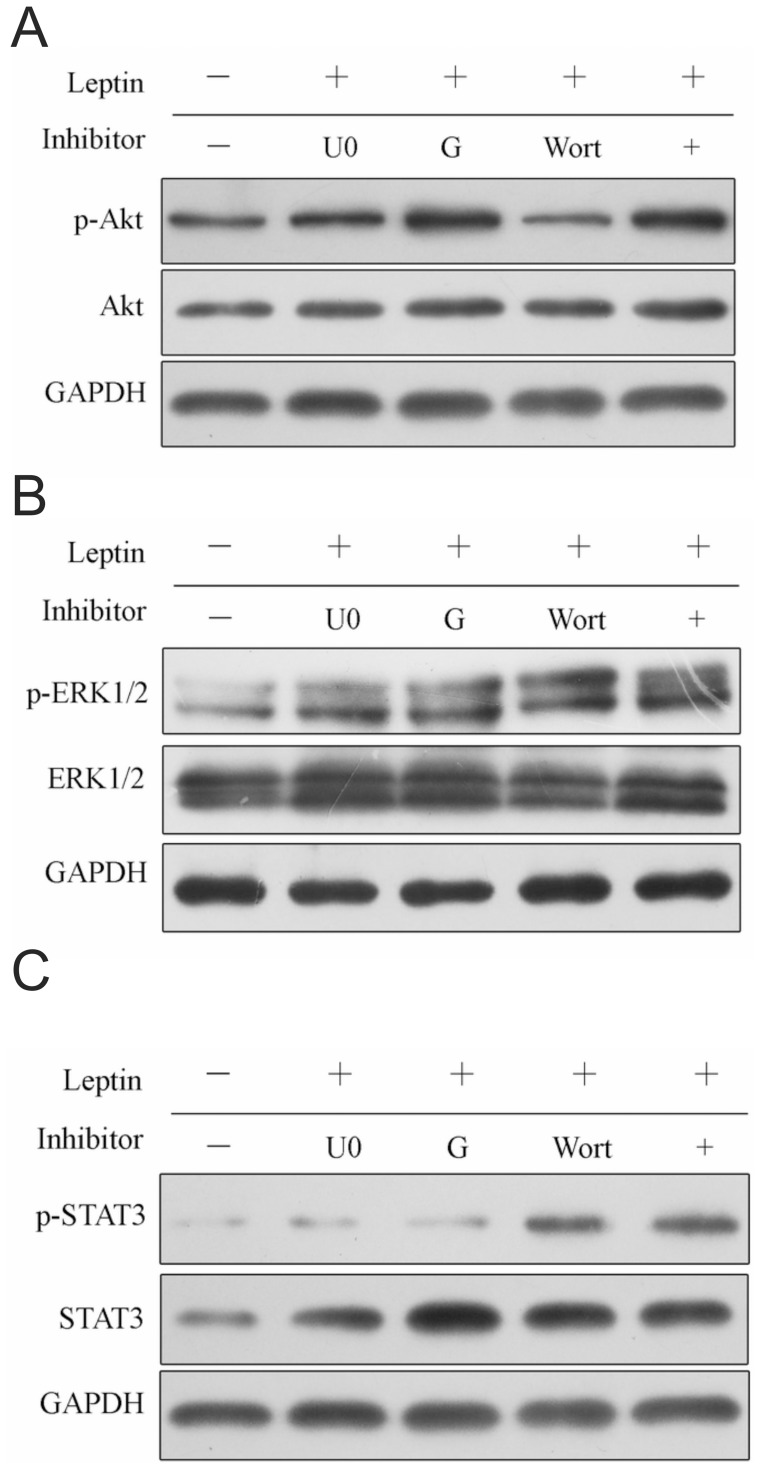
Pharmacological inhibitors of JAK, PI3K/Akt, and MEK/ERK1/2 prevent NP cells growth from leptin induction.After 1-day serum deprivation, NP cell were treated vehicle (control), 10 ng/ml leptin (Lep), 40 µM AG490 (AG), 250 nM wortmannin (Wort), 10 µM U0126 (U0126), or 10 ng/ml leptin together with 40 µM AG490 (Lep+AG), 250 nM wortmannin (Lep+Wort), 10 µM U0126 (Lep+U0126), 40 µM AG490 and 10 µM U0126 (Lep +U0126+ AG), 40 µM AG490 and 250 nM wortmannin (Lep+AG+Wort), 10 µM U0126 and 250 nM wortmannin (Lep+U0126+Wort), 10 µM U0126, 40 µM AG490 and 250 nM wortmannin (Lep+U0126+ Wort+AG) in serum-free medium for 48 h. Values are presented as mean ±SD (n = 4). The statistically differences compared with the control are noted as *p<0.05, and ***p<0.001. Data represent three independent experiments.